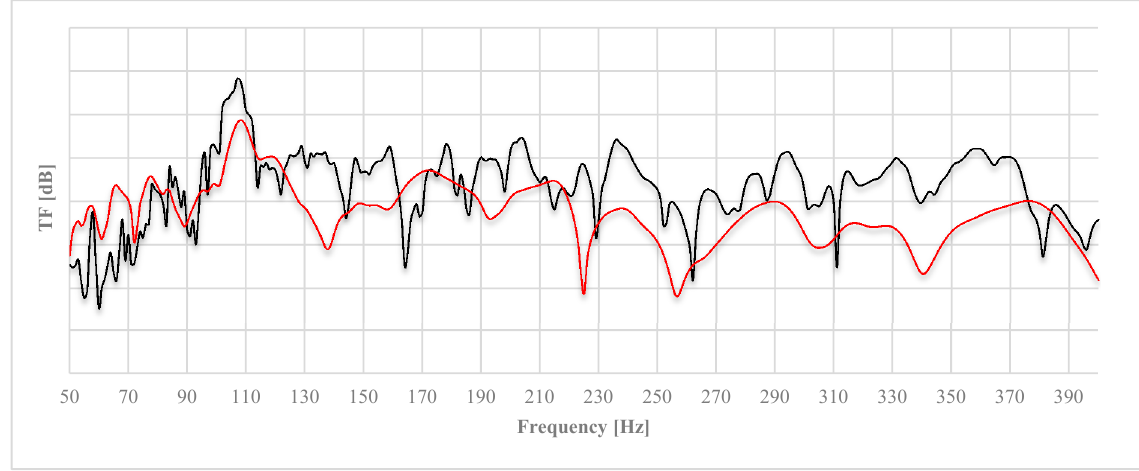
Figure 27. Vibroacoustic transfer functions (TF) from the car roof center to the ear node for TCA (black line) and PP23CF OPTIMIZED (red line).